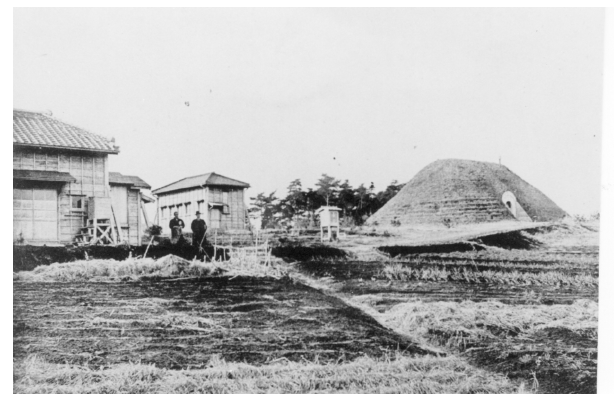
Figure 4. The “Ishimuro” variation house (right) and the abso- lute hut (left). Ishimuro was used till the 1980s (photo supplied by Kakioka Magnetic